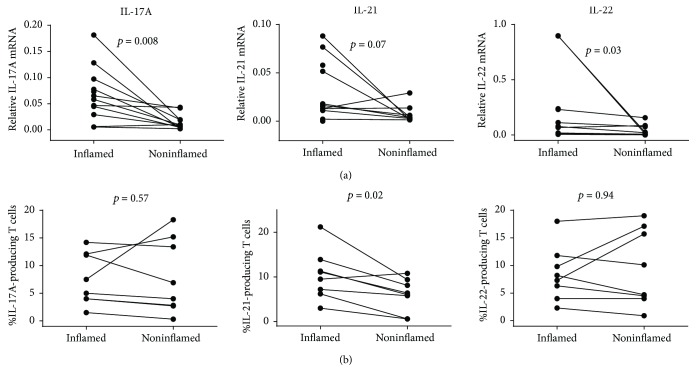
Mucosal gene expression and LP T cell producing IL-17A, IL-21, and IL-22 at baseline in inflamed and noninflamed mucosa. Gene expression was determined by rtPCR (a) and frequencies of IL-17A-, IL-21-, and IL-22-producing cells among LP CD3+ T cells were determined by flow cytometry (b). Gene expression data is displayed as the normalized ratios between the relative expression of the gene of interest and the housekeeping gene HPRT-1. Wilcoxon signed-rank test for comparison was applied on paired samples (rtPCR: IL-17A n = 11; IL-21 n = 9; IL-22 n = 9; flow cytometry: n = 8 for each cytokine).